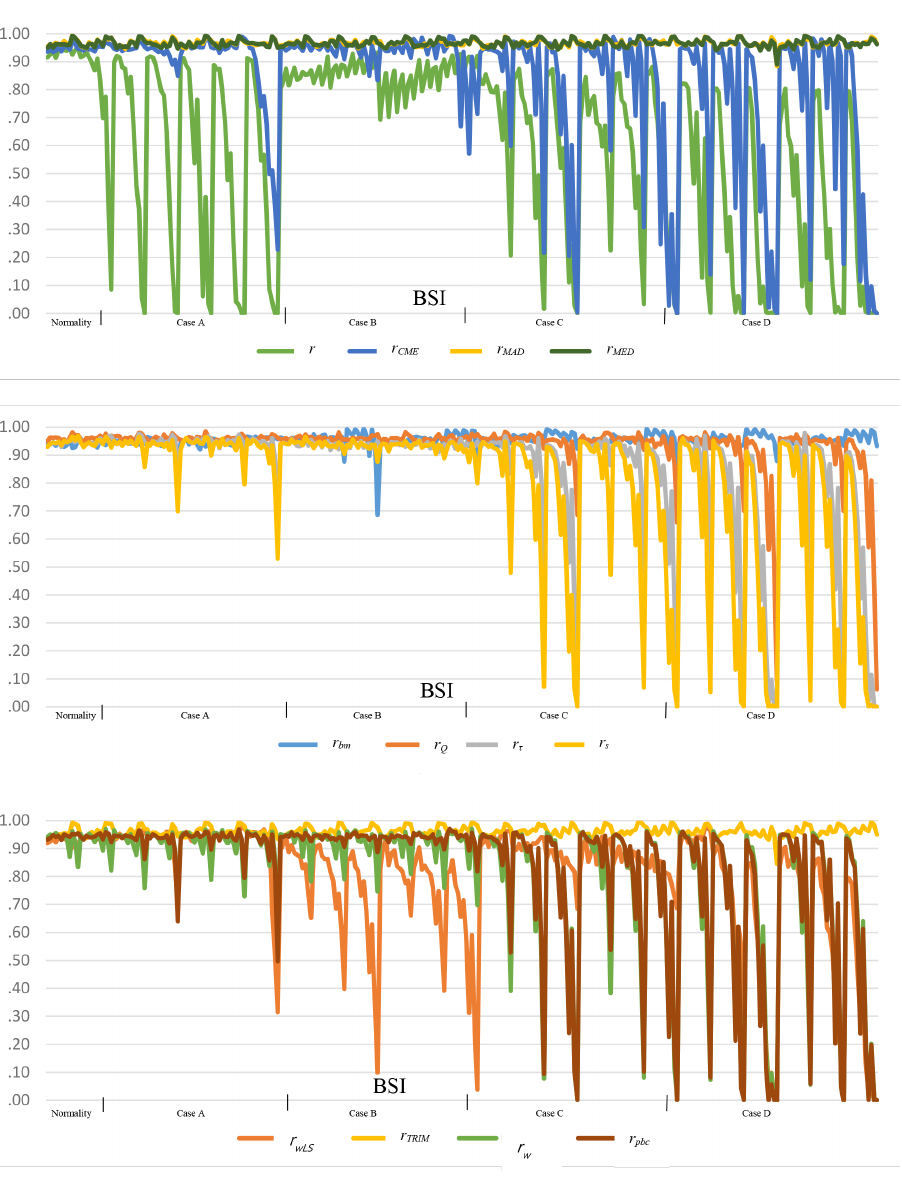
Coverage Probabilities of BSI, BPI, and BCaI for r and 11 Robust Correlations Across 300